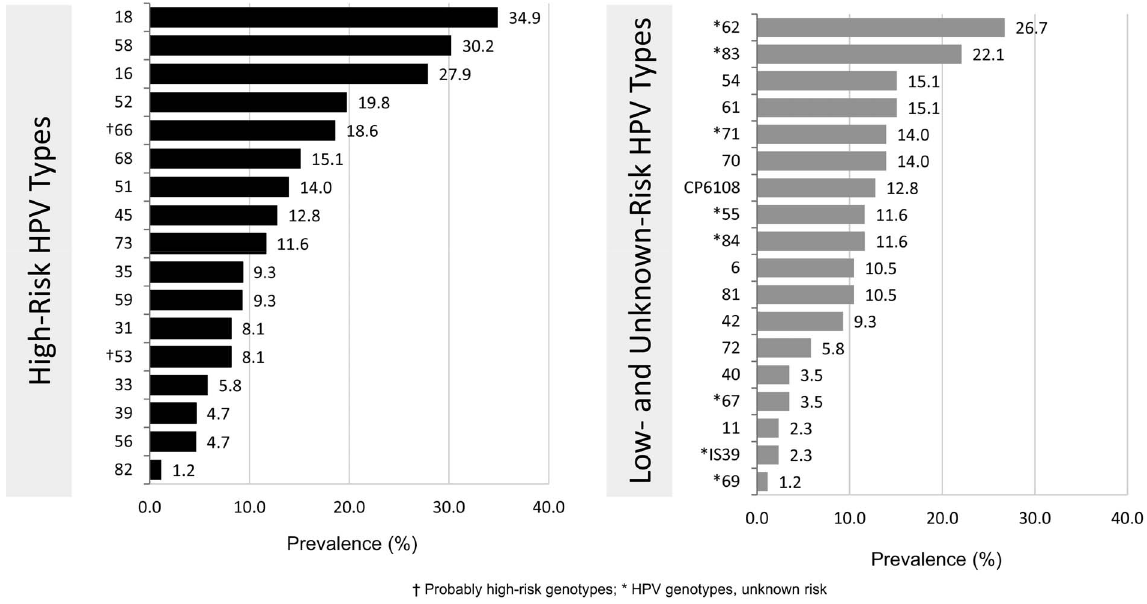
Figure 1. Genotype-specific distribution of high-risk and low/undetermined-risk HPV types detected in HIV-positive women. The prevalence does not total 100% since several women were infected with multiple HPV types.